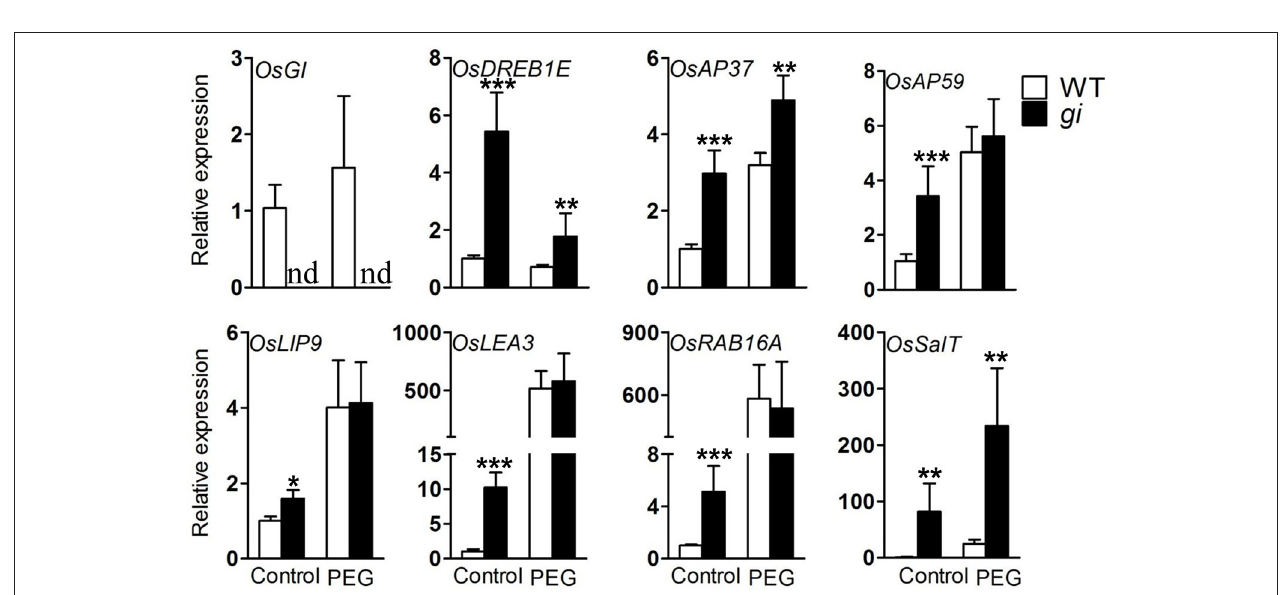
FIGURE 7 | Expression of water deficiency-related genes in WT and osgi leaves. WT and osgi plants were grown under normal conditions for 15 days and then cultured in 18% PEG 8000 or normal culture media for 2 days. Leaves were sampled 8 h after lights-on. Total RNA was extracted from the leaves and used for qRT-PCR. All data represent the mean of three biological replicates, with error bars indicating SD. Expression of OsACTIN was used as the internal control. Significant differences relative to the corresponding WT strain are indicated with asterisks ( *** P < 0.001; ** P < 0.01; and * P <